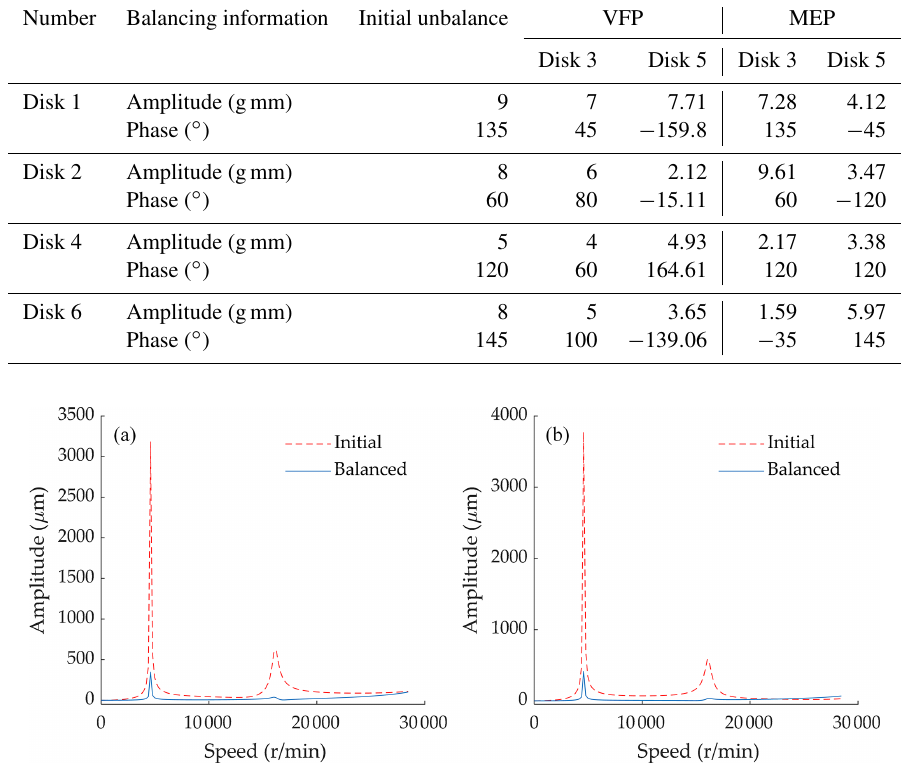
Figure 5. Comparison of unbalance response before and after the balancing procedure. (a) Left-hand side. (b) Right-hand side.